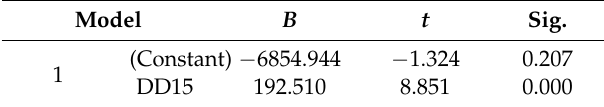
Table 3. Compliance with linearity assumption and coefficients of the simple linear regression model. D3 building.